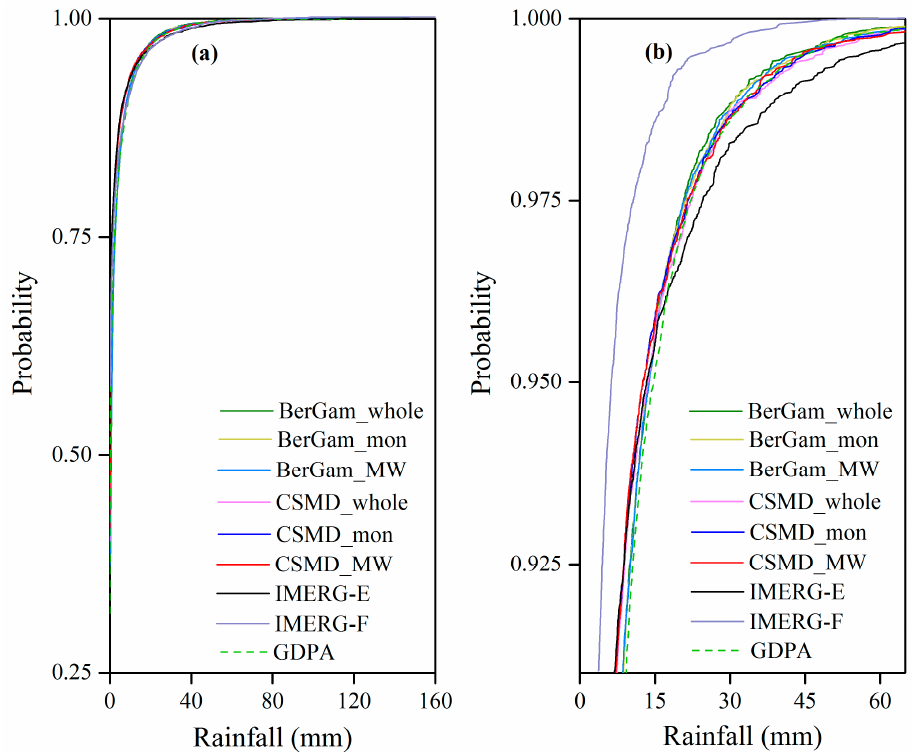
Figure 10. Cumulative probability distribution (CDF) of all precipitation datasets used, including the raw and corrected satellite precipitation IMERG-E, the post-real-time IMERG-F and the ground reference precipitation GDPA. ( a ) Over all intensities of the precipitation series, and ( b ) over relatively high intensities of precipitation series with their corresponding CDF values of 0.91–1.